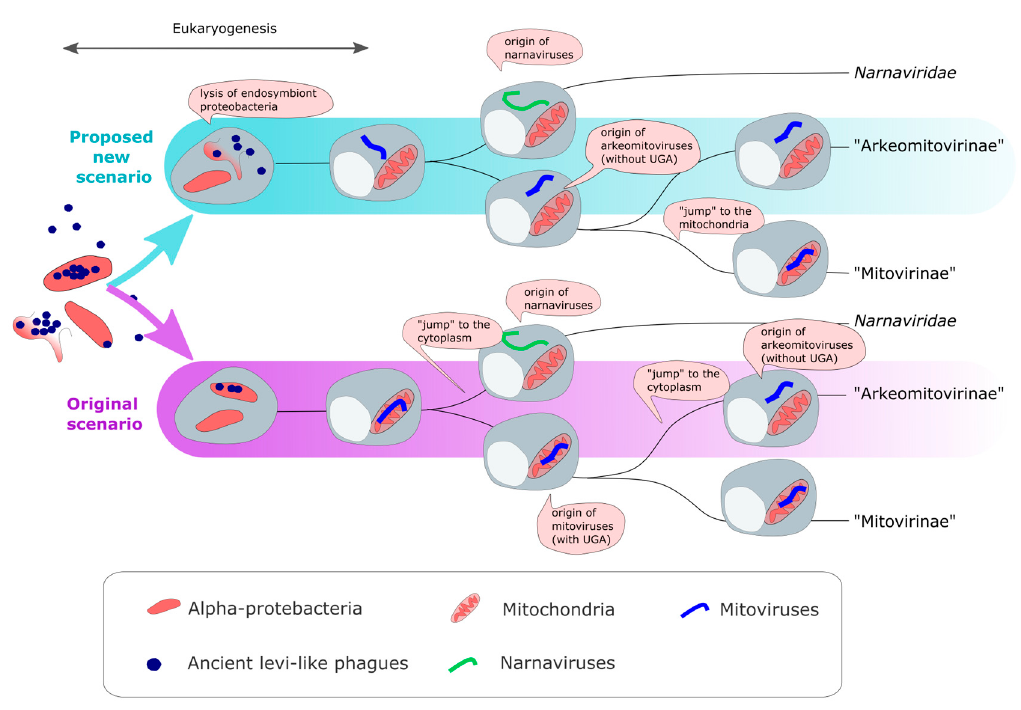
Figure 4. Currently accepted and proposed evolutionary scenarios of mitovirus origin. The scenarios are described in Sections 3.5 and 3.6 of the paper.